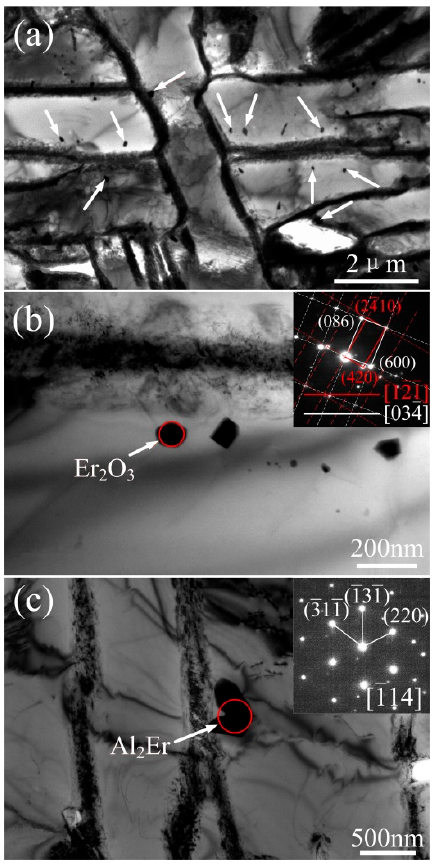
Figure 9. ( a ) TEM images of Ti6Al4V-0.6Er casting alloy; ( b ) enlarged view of Er 2 O 3 phase; and ( c ) Al 2 Er phase. The insets show the selected area diffraction patterns of the two phases.